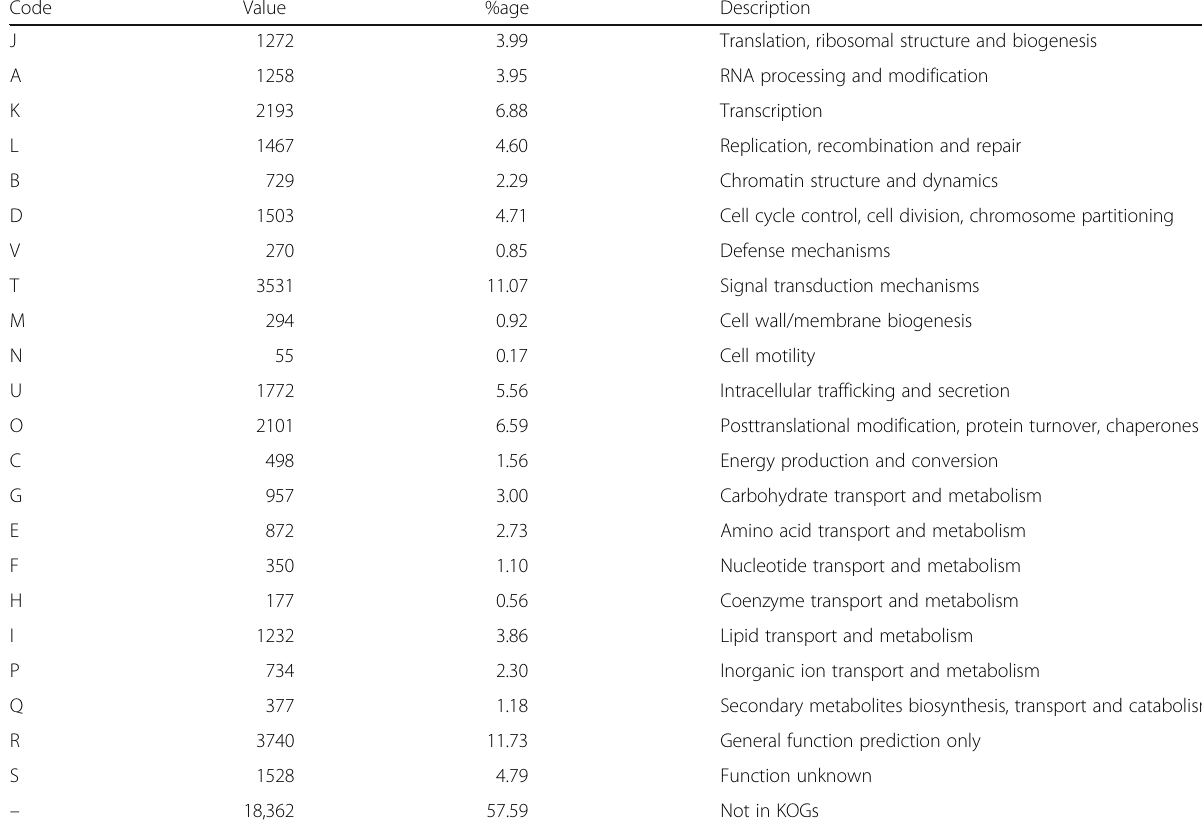
Table 4 Number of genes associated with general KOG functional